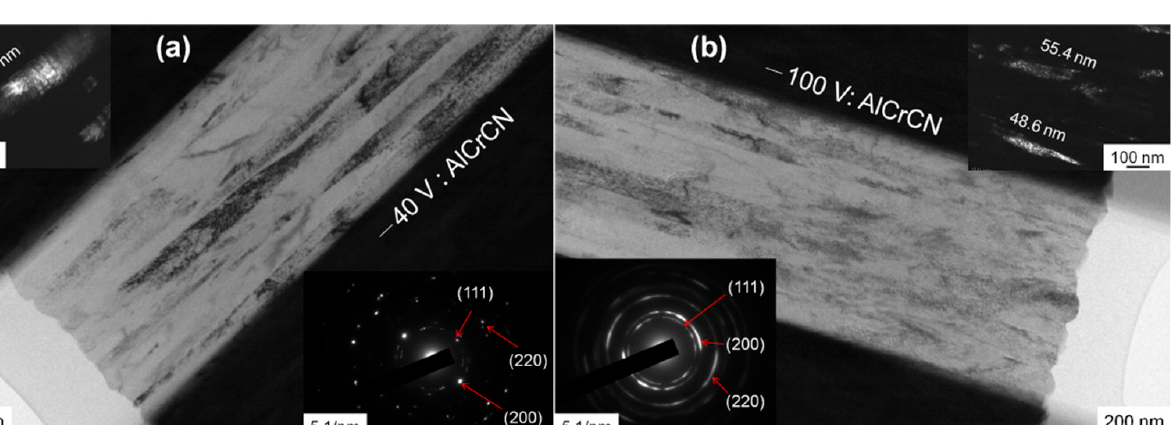
Figure 8. Nanoindentation results of AlCrCN films as a function of bias voltage. Figure 9. Rockwell indentation results of AlCrCN deposited as function of ( a ) C 2 H 2 flow rate and ( b ) bias voltage. 4. Conclusions Our objective in this work was to elucidate the effects of C 2 H 2 flow rate and DC bias voltage on the properties of C-doped AlCrN coatings deposited using HiPIMS. Increasing the C 2 H 2 flow rate from 0 to 20 sccm reduced the ratio of sp 3 /sp 2 and the grain size, as well